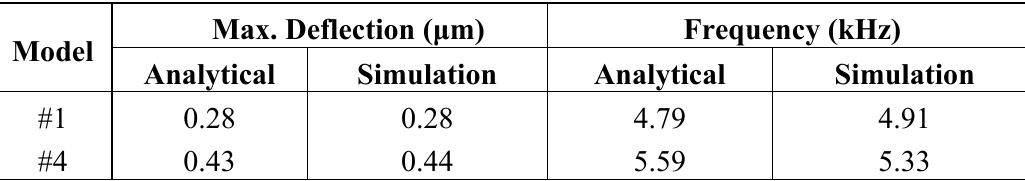
Table 2. Comparison between analytical and simulation results for uniform width rectangular and trapezoidal